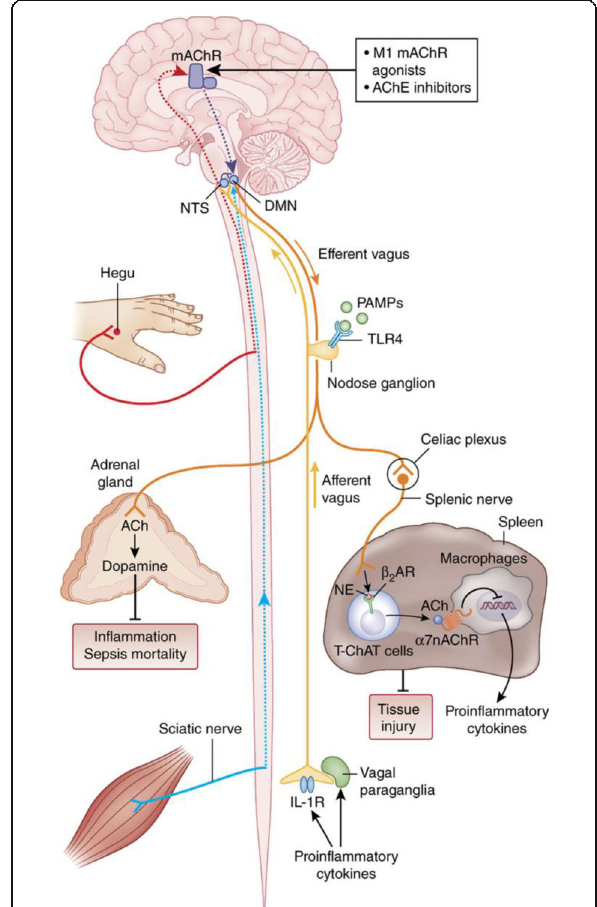
Fig. 1 The inflammatory reflex. In the inflammatory reflex, the activity of afferent vagus nerve fibers residing in the nodose ganglion is stimulated by cytokines and pathogen-associated molecular patterns (PAMPs). The signal is transmitted to the NTS. Reciprocal connections between the NTS and DMN mediate communication with and activation of efferent vagus nerve fibers from the DMN. The signal is propagated to the celiac ganglia and the superior mesenteric ganglion in the celiac plexus, where the splenic nerve originates. Norepinephrine (NE) released from the splenic nerve interacts with β 2 -adrenergic receptors ( β 2 -ARs) and causes the release of acetylcholine (ACh) from T cells containing functional choline acetyltransferase (T-ChAT cells). ACh interacts with α 7nAChRs on macrophages and suppresses proinflammatory cytokine release and inflammation. The inflammatory reflex can be activated through brain mAChR-mediated mechanisms by centrally-acting M1 mAChR agonists and acetylcholinesterase (AChE) inhibitors. Somatosensory activation by electroacupuncture at the Hegu point also causes activation of brain mAChR signaling, which then results in activation of efferent vagus and splenic anti-inflammatory signaling. Electroacupuncture at a different acupuncture point activates sciatic nerve signals, which by unknown mechanisms convert to efferent vagus nerve signaling to the adrenal medulla, resulting in dopamine release. Dopamine suppresses inflammation and improves survival in a model of sepsis. Vagus nerve and splenic nerve signaling mediated through α 7nAChR on splenocytes controls inflammation in acute kidney injury and alleviates the condition. (Figure created by Debbie Maizels, Springer Nature, for Pavlov and Tracey 2017; reprinted, with permission, from the authors in conjunction with Springer